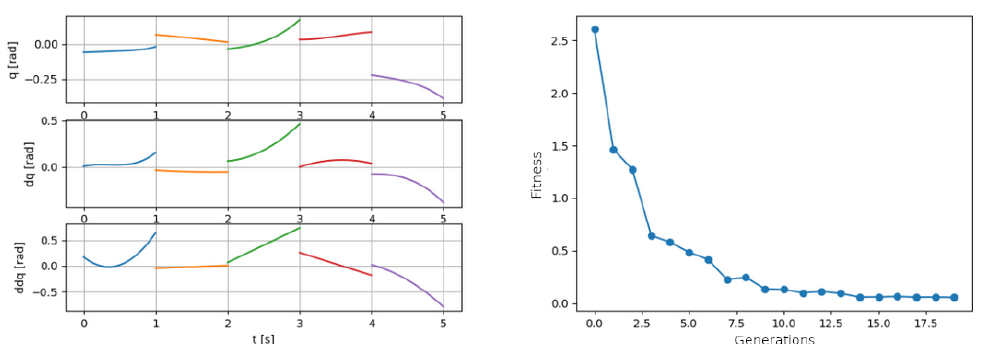
Figure 6. The behavior of the algorithm without setting the boundary condition. The best-achieved solution is visualized on the ( left ), and the fitness change through generations is on the ( right